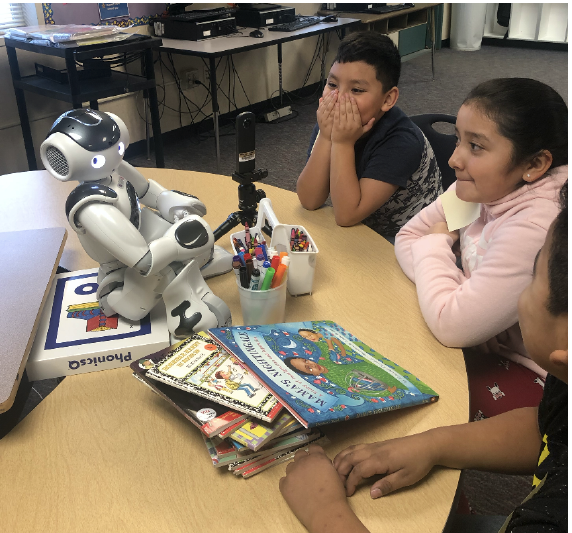
Figure 2. In this image, a student can be seen covering his mouth in surprise or shyness and simultaneously social referencing another student for confirmation about what to do